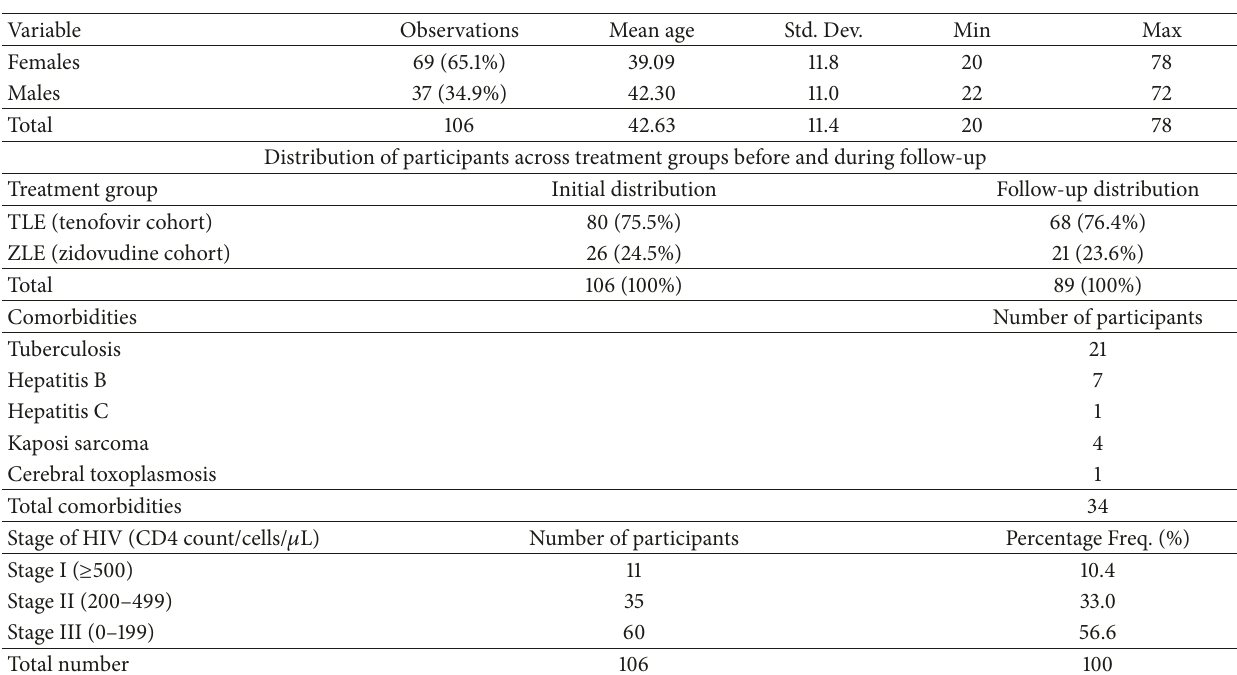
Table 1: Demographic and baseline characteristics of the study participants at